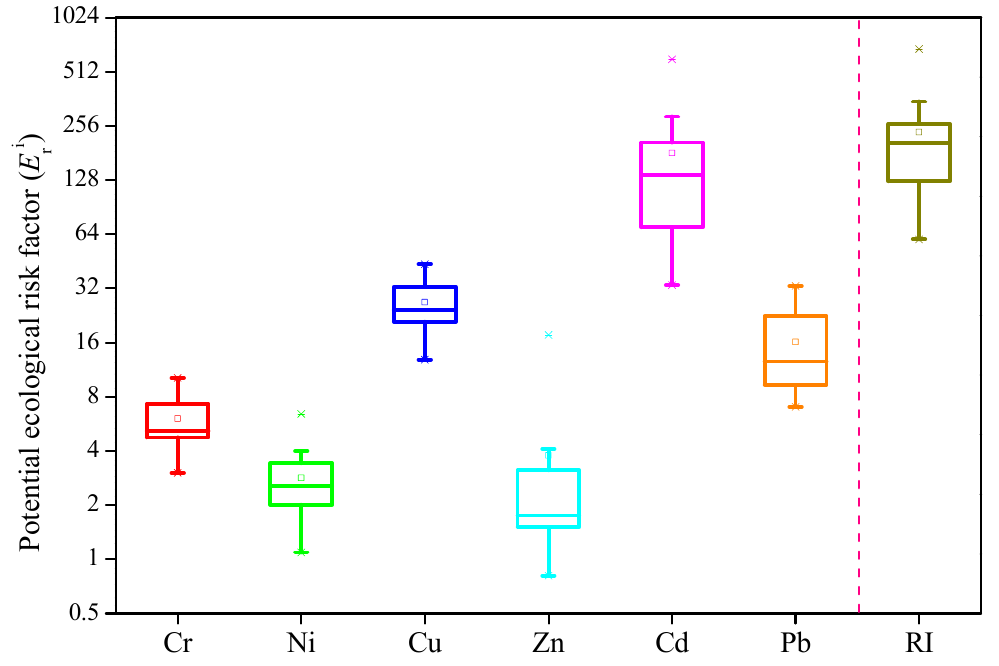
Figure 6. Box plot of potential ecological risk indexes for heavy metals in Shantou Bay.